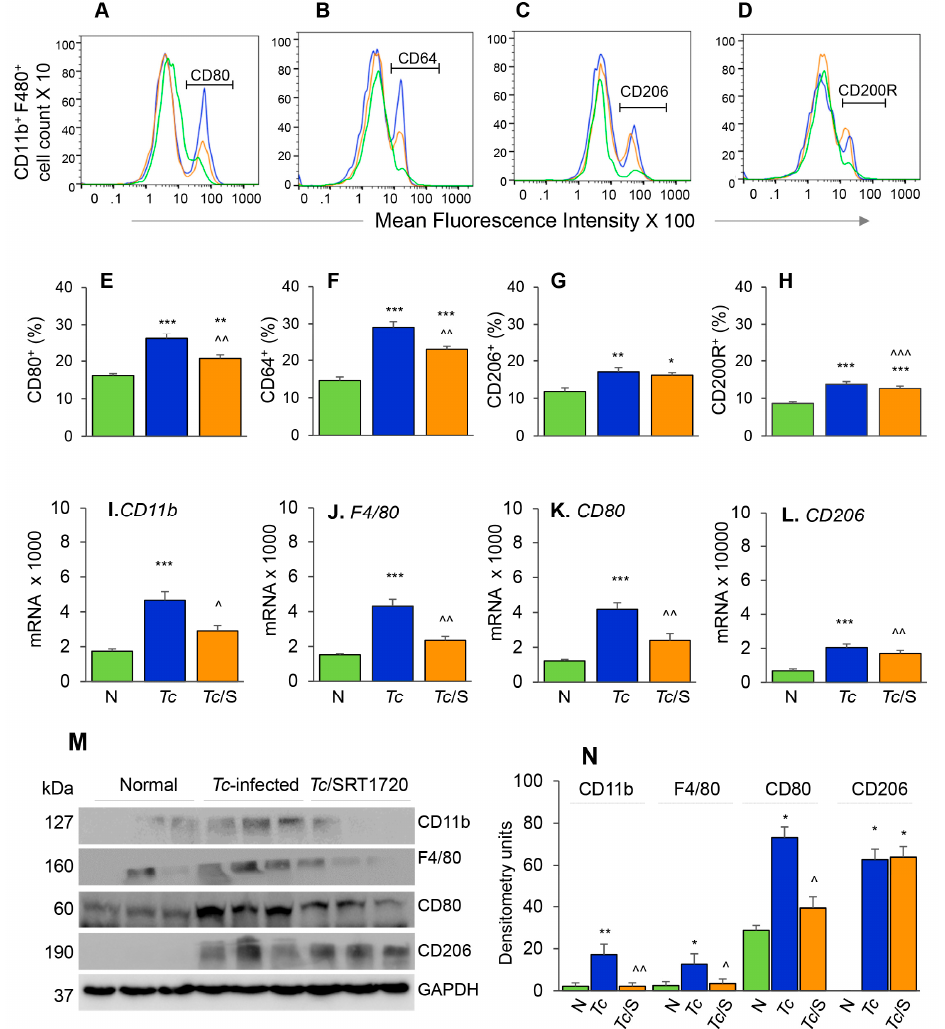
Figure 3. Phenotypic characterization of splenic M ϕ in chronic Chagas mice in presence or absence of SRT1720. Mice were infected, SRT1720-treated, and euthanized as in Figure 2A. ( A – D ) Single cell suspension of spleen cells were stained with fluorescence-conjugated antibodies, gated for CD11b and F4 / 80 M ϕ markers, and further examined for the expression of phenotypic markers of M ϕ activation by flow cytometry. Shown are representative images of mean fluorescence intensity ( x -axis) of splenocytes gated for the expression of CD80 ( A ), CD64 ( B ), CD206 ( C ), and CD200R ( D ) in normal (green), Tc -infected (blue), and infected / SRT1720-treated (orange) mice. ( E–H ) Flow cytometry was carried out in three independent experiments ( n = 3–5 mice per group per experiment) and mean percentages of CD11b + F4 / 80 + splenocytes that were CD80 + ( E ), CD64 + ( F ), CD206 + ( G ), and CD200R + ( H ) in Chagas ( ± SRT1720) mice are plotted. ( I – L ) Real-time RT-qPCR analysis of mRNA levels for CD11b, F4 / 80, CD80 , and CD206 in the spleen of normal, Tc -infected, and infected / SRT1720-treated mice. For each target gene, Ct values were normalized to GAPDH expression. ( M , N ) Representative Western blot images for splenic levels of CD11b, F4 / 80, CD80, and CD206 in normal, infected, and infected / SRT1720-treated mice (loading control: GAPDH) are shown. Densitometry analyses of the Western blot bands for target proteins, normalized to GAPDH, are shown in panel N . For panels I–N, data (mean value ± SEM) are representative of two independent experiments ( n = 3–5 mice per group per experiment, duplicate observations per mouse). Statistical significance is plotted as * normal vs. infected and ˆ Tc only vs. Tc / SRT1720. * or ˆ p value < 0.05; ** or ˆˆ p value < 0.01; and *** or ˆˆˆ p value < 0.001.